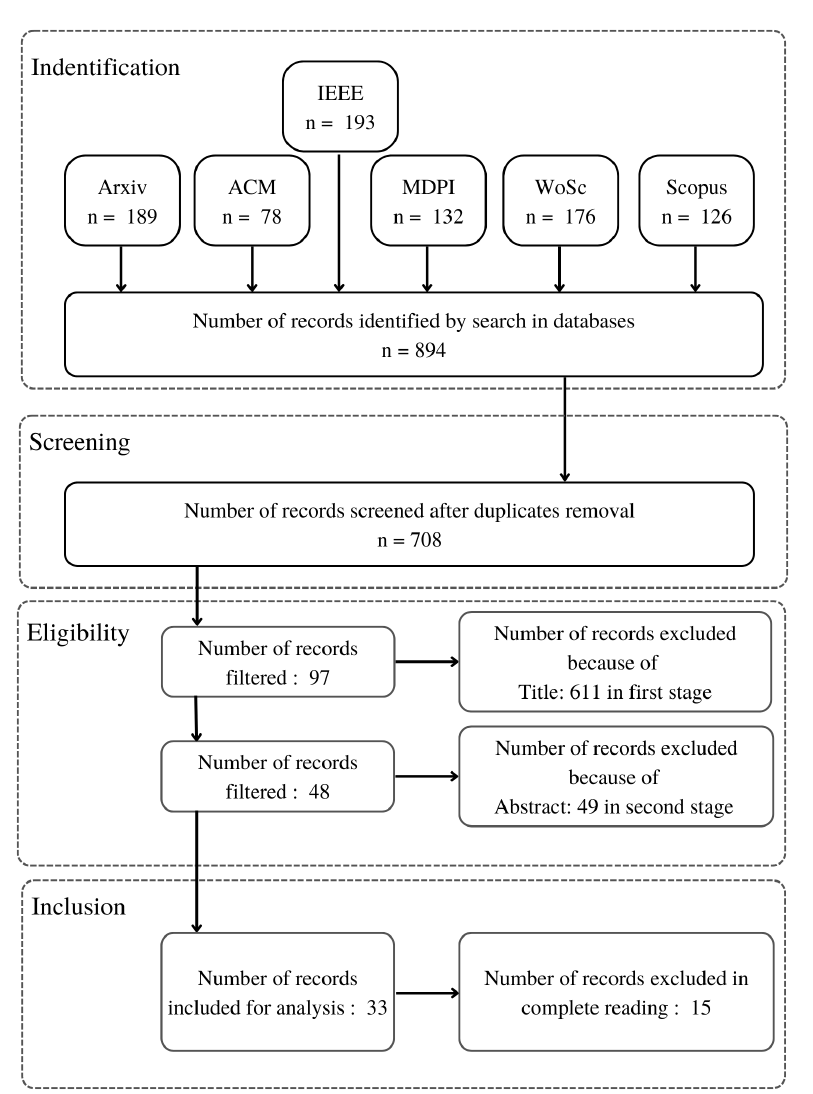
Figure 1. Paper selection flow diagram for text classification in biomedical